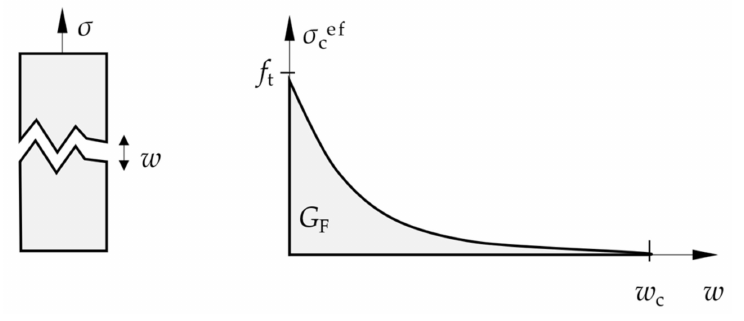
Figure 9. Fracture energy.